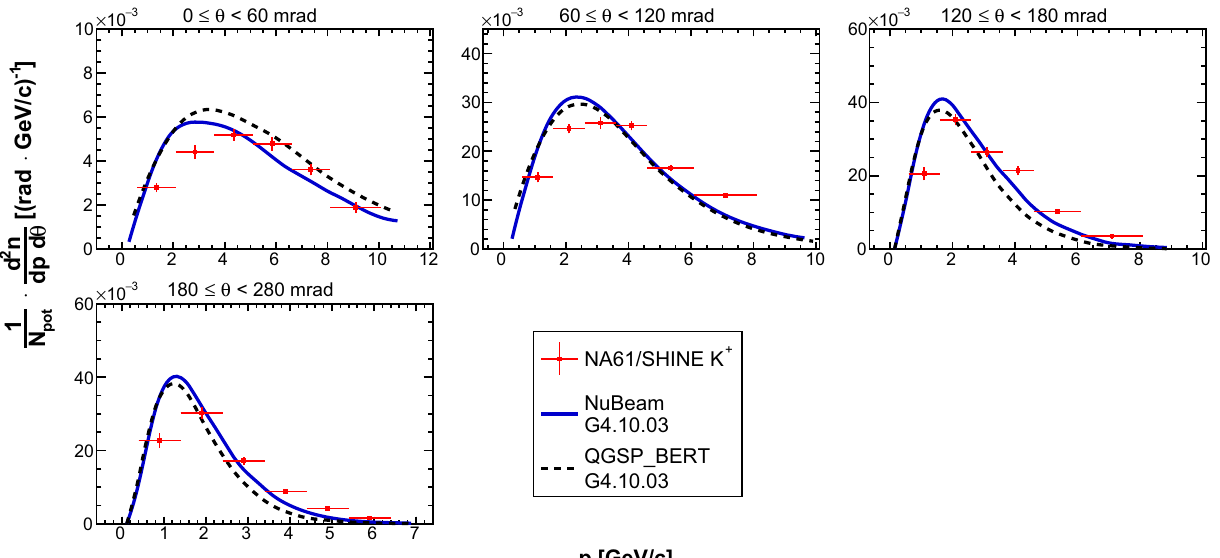
Fig. 36 Double differential yields of positively charged kaons for the second upstream longitudinal bin (18 ≤ z < 36 cm). Vertical bars represent the total uncertanties. Predictions from the NuBeam (solid